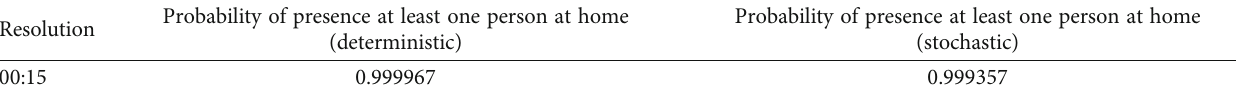
Table 8: A step from the Markov chain considering the family